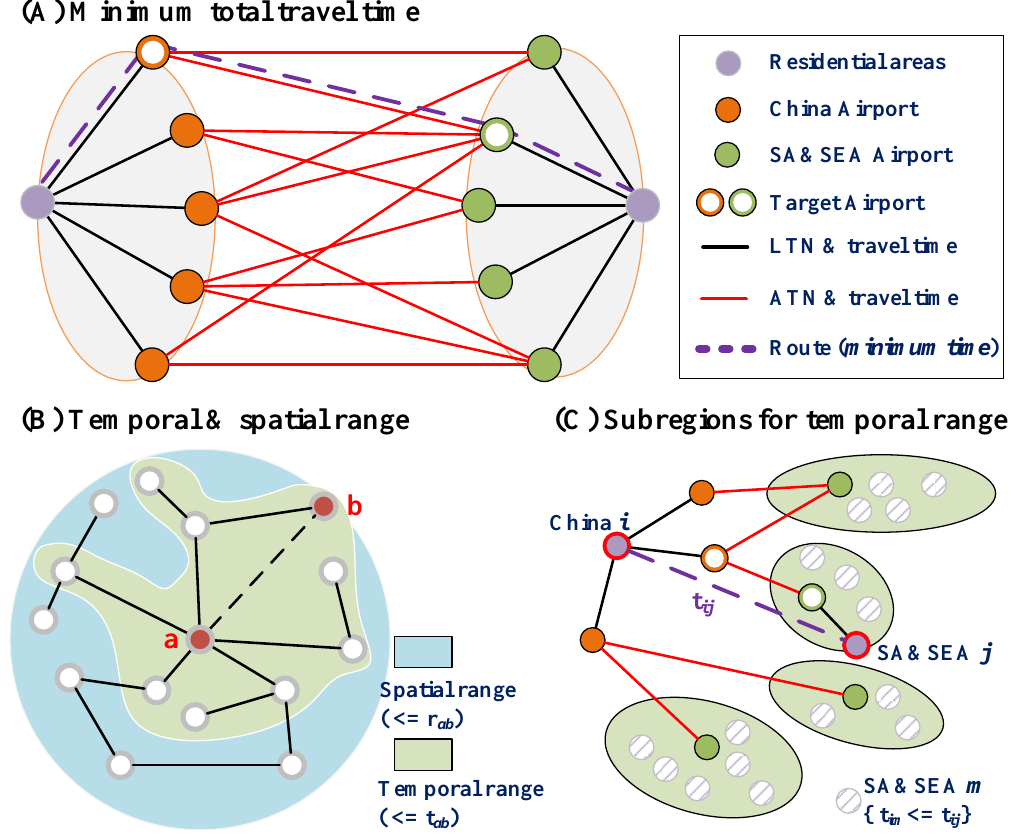
Figure 3. The sketch map of ( A ) minimum total travel time between residential areas, ( B ) differences between temporal range and spatial range for the radiation model, ( C ) subregions for the temporal range between China residential area i and SA&SEA residential area j .